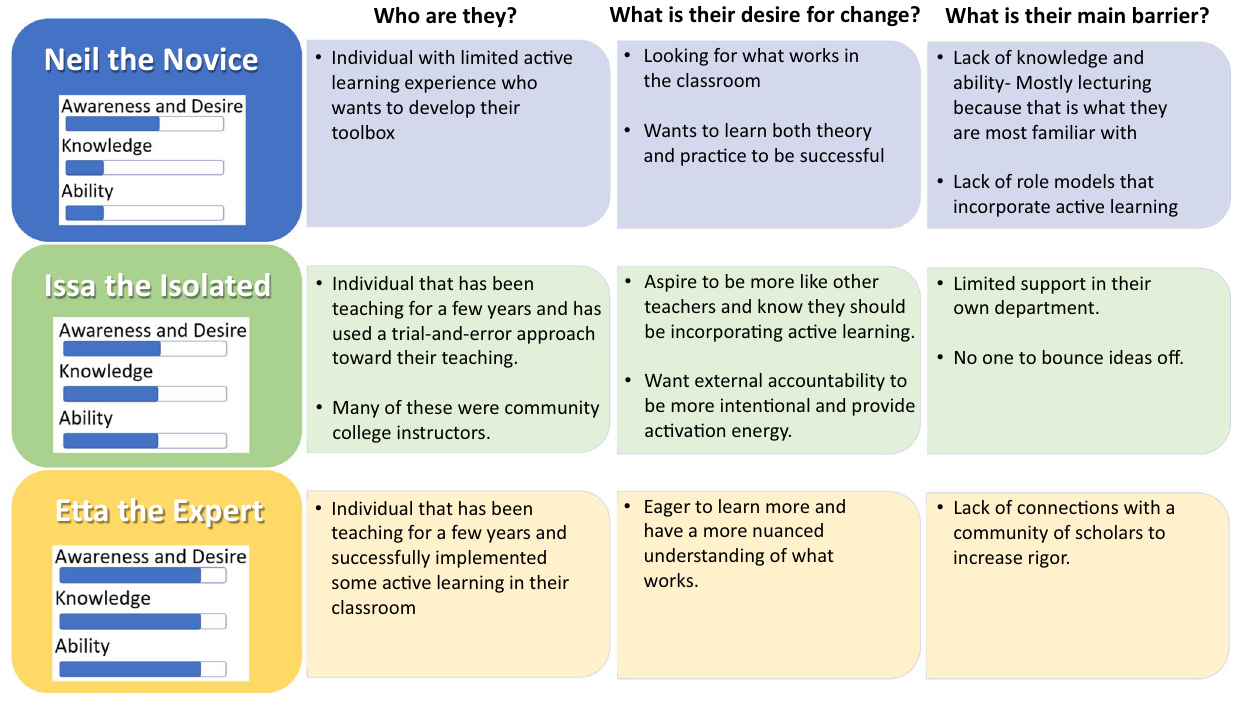
Fig. 2 Summary of personas developed from interviews. The three personas that characterized the Fellows in the PALM Network were Neil the Novice, Issa the Isolated, and Etta the Expert. Each persona has a range of ADKAR features that represent their pedagogical develop-